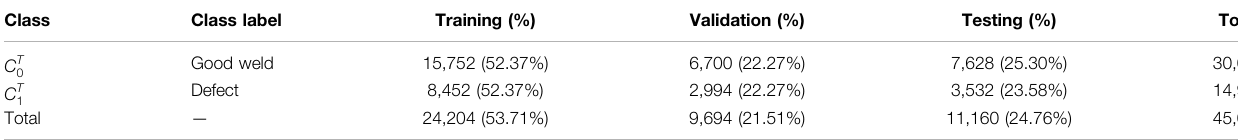
TABLE 3 | Data distribution of the welding data set for two-class classi fi cation.